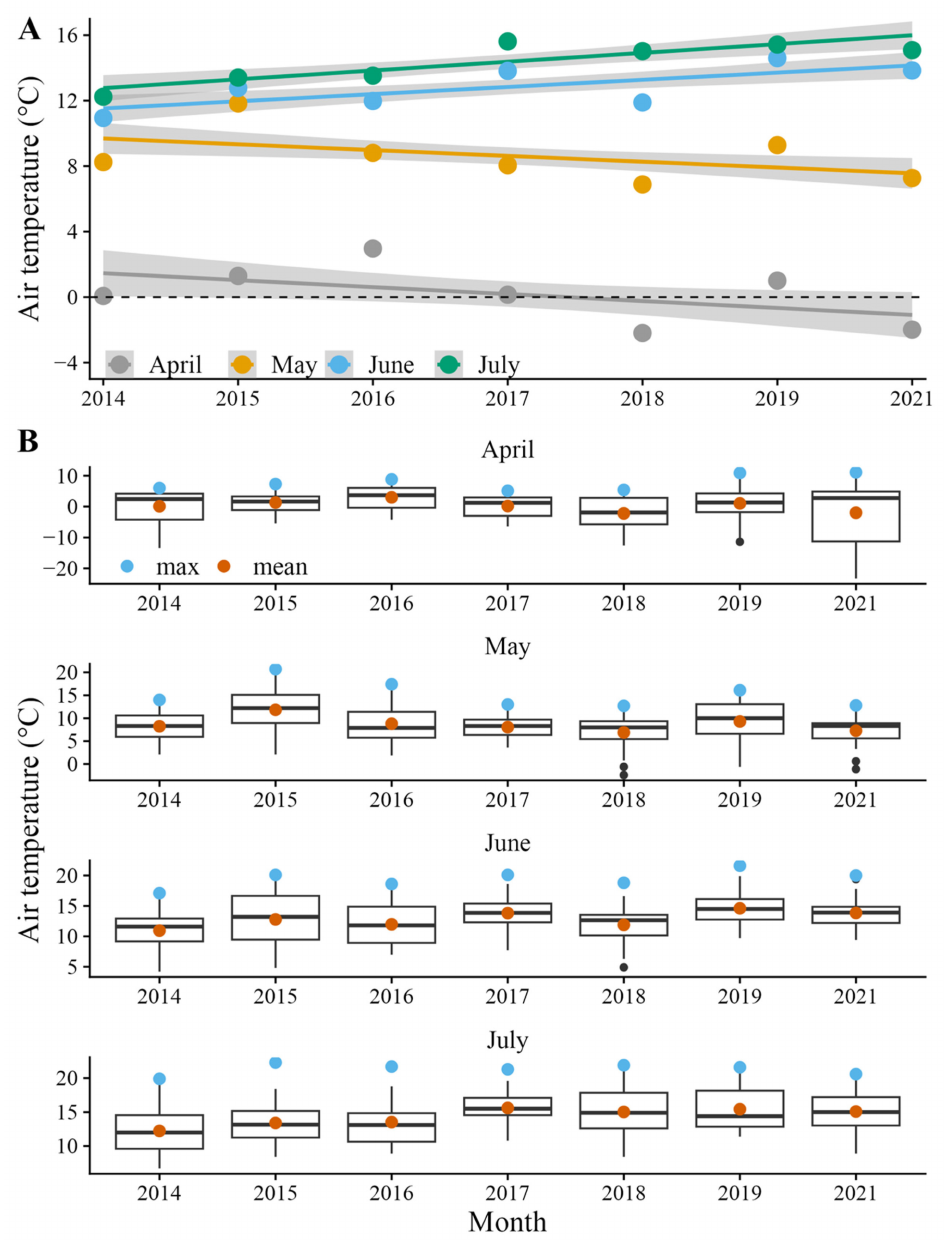
Figure 4. Monthly average air temperatures ( ◦ C) for the study period from the Little Chena Ridge SNOTEL station on the Yukon River. ( A ) Gray area represents 95% confidence intervals. ( B ) Box plots of air temperature by month. Bold lines represent median temperature. Blue dots represent maximum temperature and orange dots represent mean